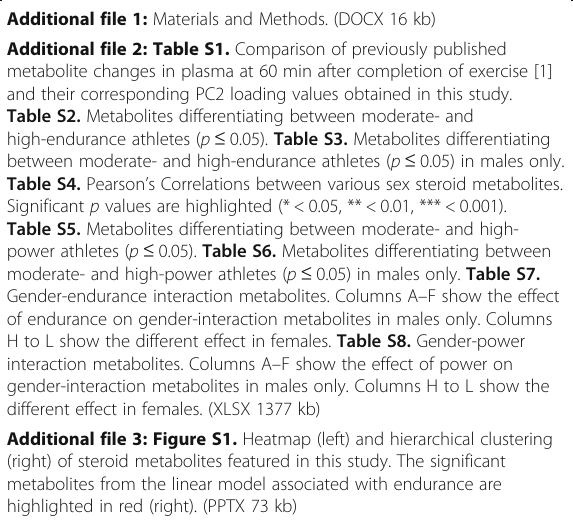
Table S4. Pearson ’ s Correlations between various sex steroid metabolites. Significant p values are highlighted (*< 0.05, ** <0.01, ***< 0.001). Table S5. Metabolites differentiating between moderate- and high- power athletes ( p ≤ 0.05). Table S6. Metabolites differentiating between moderate- and high-power athletes ( p ≤ 0.05) in males only. Table S7. Gender-endurance interaction metabolites. Columns A – F show the effect of endurance on gender-interaction metabolites in males only. Columns H to L show the different effect in females. Table S8. Gender-power interaction metabolites. Columns A – F show the effect of power on gender-interaction metabolites in males only. Columns H to L show the different effect in females. (XLSX 1377 kb) Additional file 3: Figure S1. Heatmap (left) and hierarchical clustering (right) of steroid metabolites featured in this study. The significant metabolites from the linear model associated with endurance are highlighted in red (right). (PPTX 73 kb) Abbreviations ATP: Adenosine triphosphate; DAGs: Diacylglycerols; ESI: Electrospray ionization; FA: Fatty acid; HESI-II: Heated electrospray